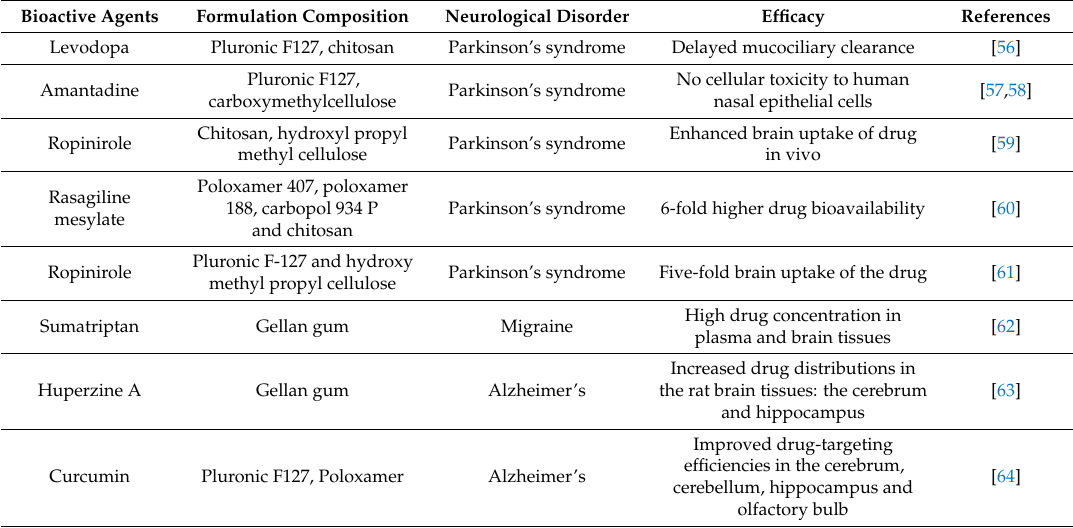
Table 2. Intranasal administration of bioactive agents via in situ